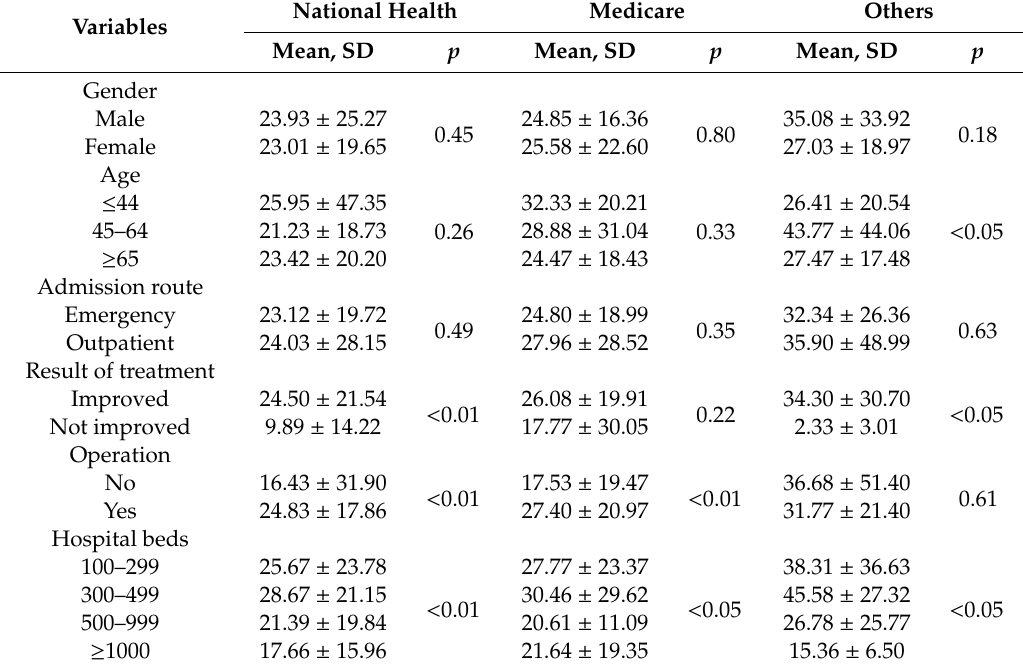
Table 3. Di ff erence of the length of stay according to general